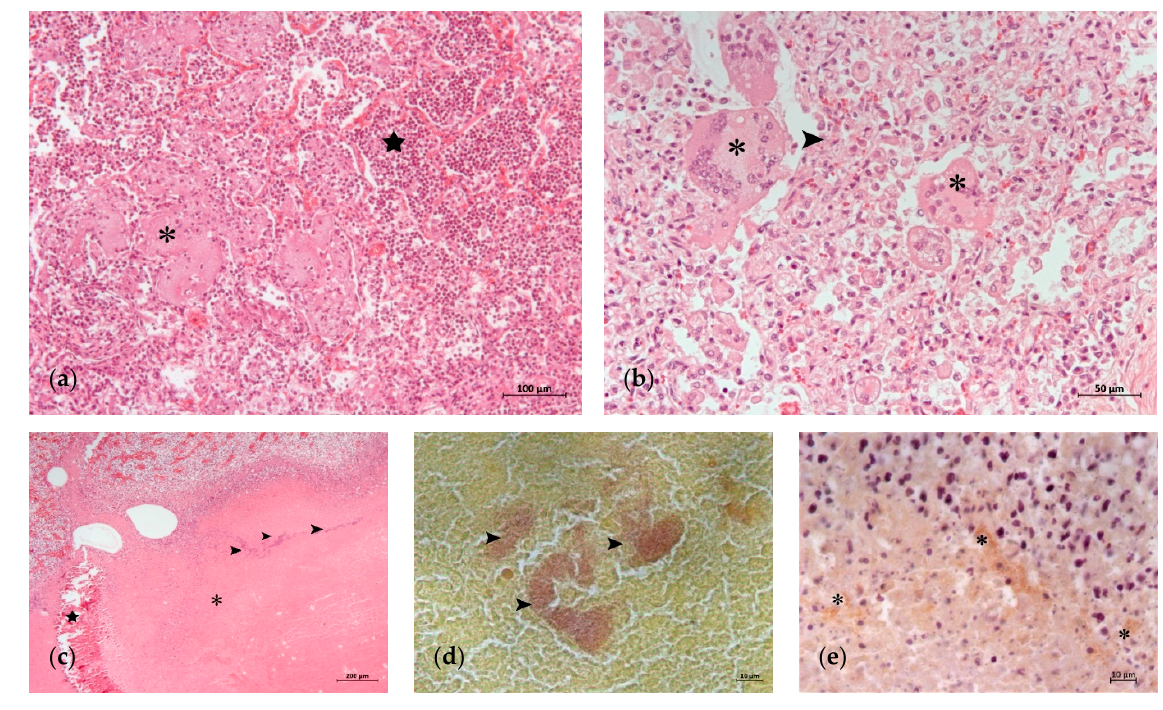
Figure 3. Lung lesions in which infection agents other than M. bovis are involved: ( a ) fibrinous bronchopneumonia with abundant fibrin (asterisk) and infiltrate of neutrophils in the alveolar lumens (star) (H-E); ( b ) interstitial pneumonia with thickening of alveolar septa (arrowhead) and syncytial cells (asterisks) (H-E); ( c ) extensive caseonecrotic focus (asterisk) with bacterial colonies inside (arrowheads) and areas of calcification (star) (H-E); ( d ) detail of Gram-positive bacterial colonies (arrowheads) in the caseonecrotic focus of ( c ); ( e ) detail of M. bovis antigen at the periphery of the caseonecrotic focus of ( c ) (asterisk) (IHC).